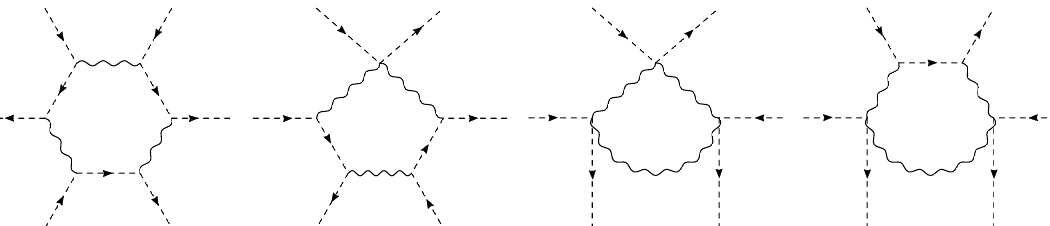
Figure 14 . One loop diagrams that contribute to the wave-function renormalization.